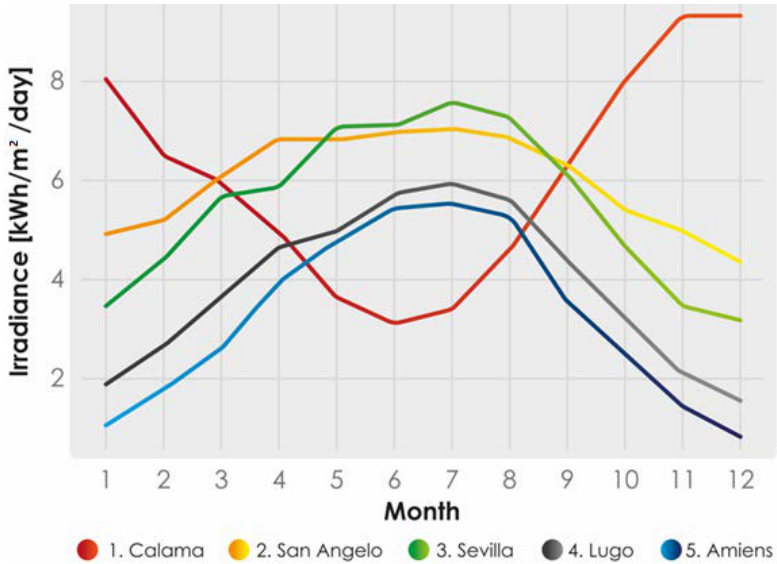
Figure 2. Irradiance for each location.